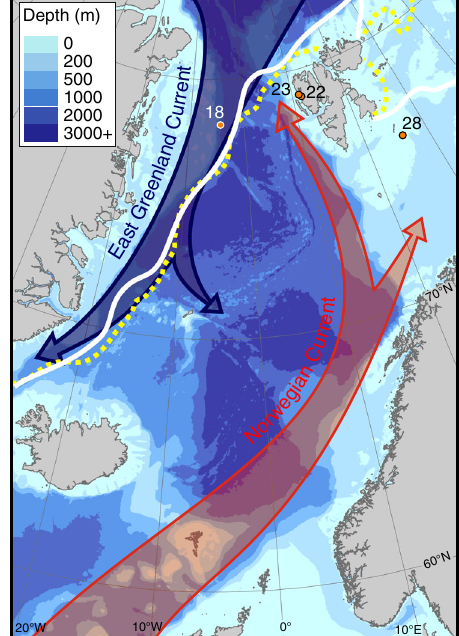
Fig. 1 Location of sites where L. helicina were collected in June 2012. Solid white line indicates the maximum sea ice extent in the preceding winter (March 2012 average). Dashed yellow line indicates the average position of the sea ice edge during June 2012 when the samples were collected. The East Greenland Current, fl owing south out of the Arctic Ocean, is represented by a blue arrow. Atlantic waters, carried by the Norwegian Current, are represented by the red arrow. Bathymetry used is The GEBCO_2014 Grid, version 20150318, www.gebco.net. Sea ice extent data from the National Snow and Ice Data Centre